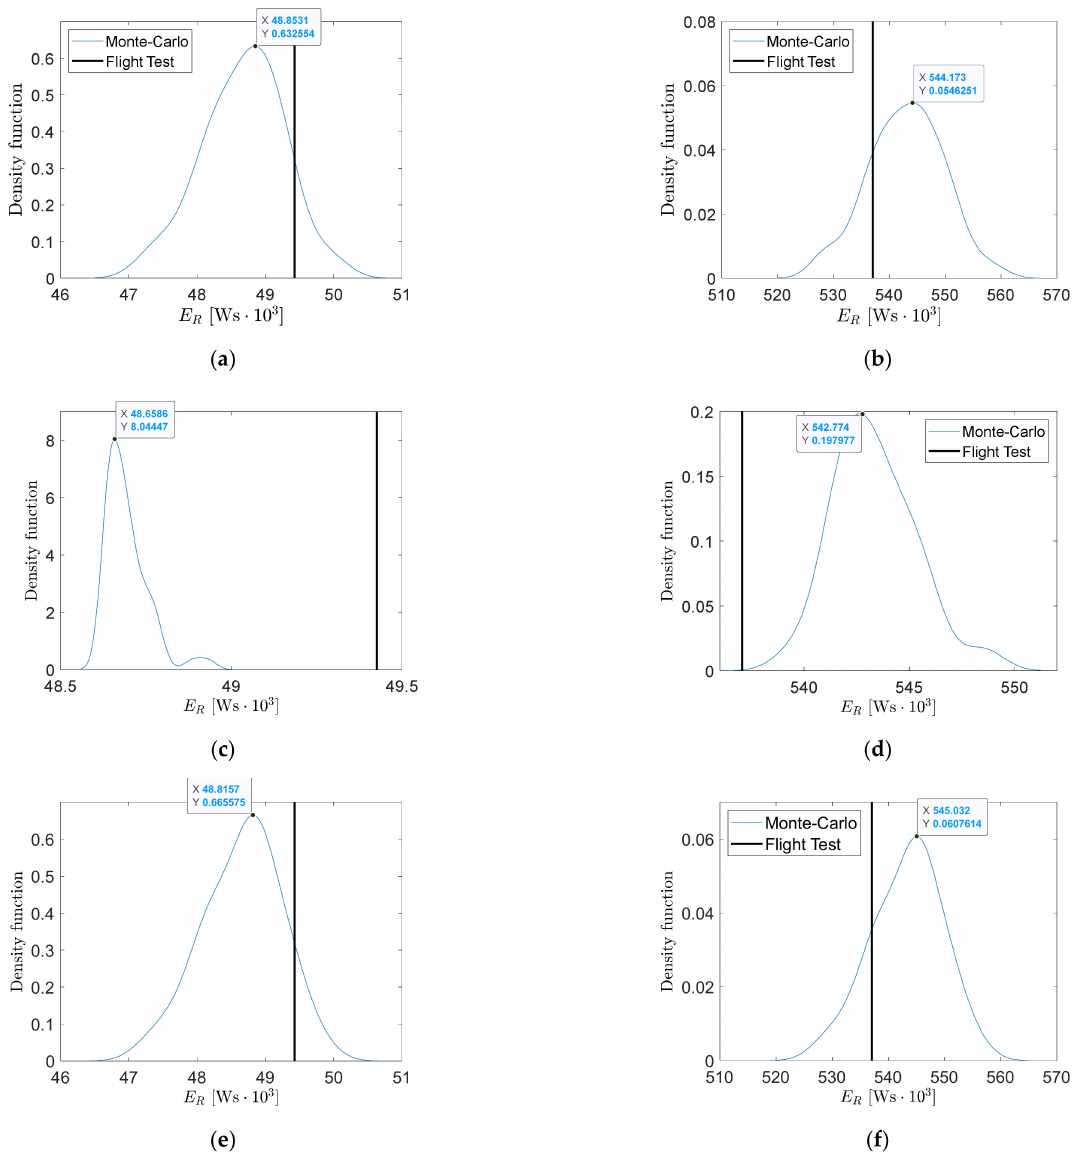
Figure 24. Kernel density estimators of consumed energy: ( a ) case 1: all disturbances, ( b ) case 2: all disturbances, ( c ) case 1: wind disturbances, ( d ) case 2: wind disturbances, ( e ) case 1: mass disturbances, and ( f ) case 2: mass